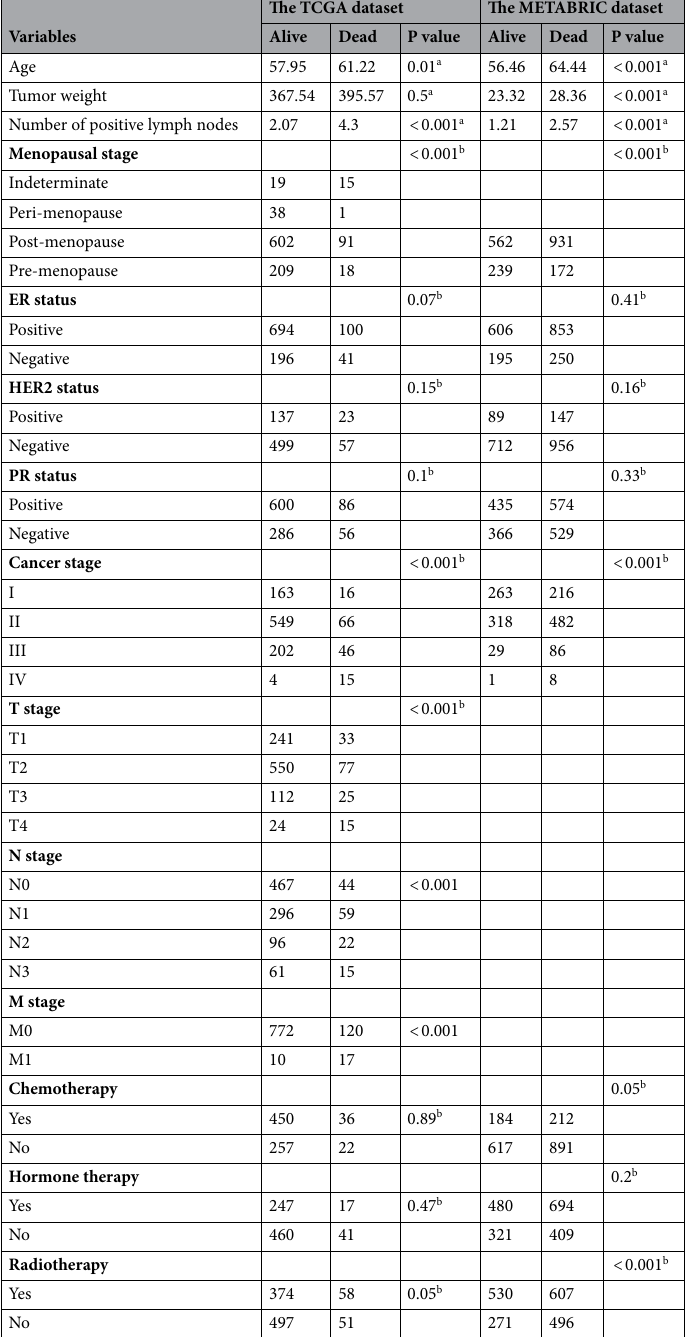
Table 1. Association between the clinical features and breast cancer patients’ mortality in the TCGA and METABRIC datasets. a and b indicate student t test and fisher exact test